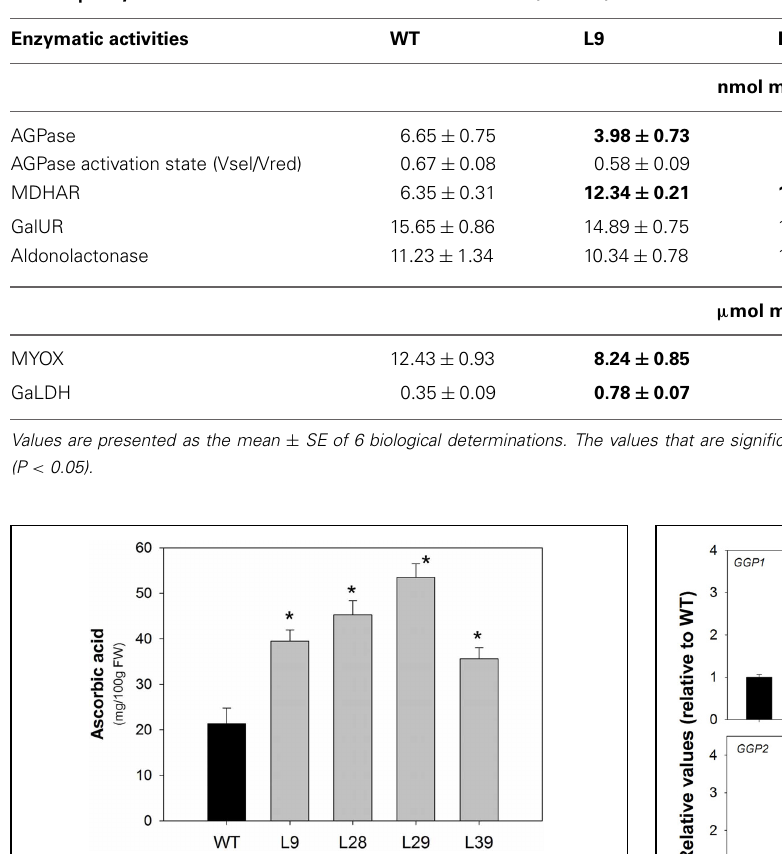
Table 3 | Enzyme activities in the B33-PPi red tomato fruits (60 DAP).